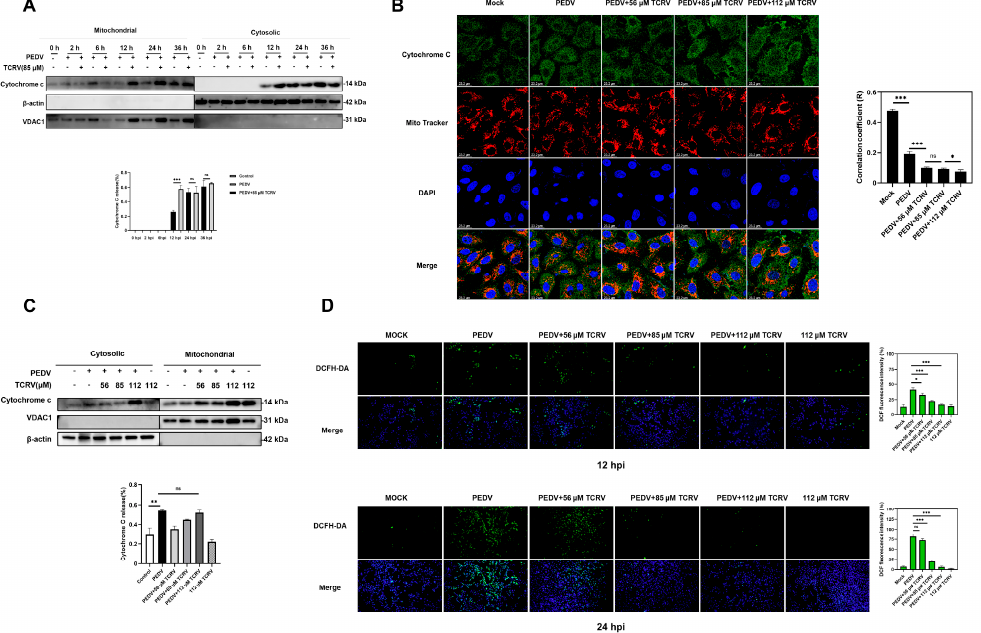
Figure 6. TCRV promotes the release of cytochrome C from the mitochondria. ( A ) To analyze